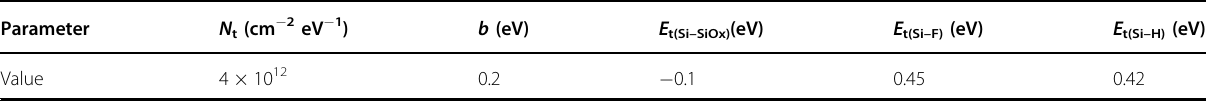
Table 2 Parameters used in the calculation 8,49